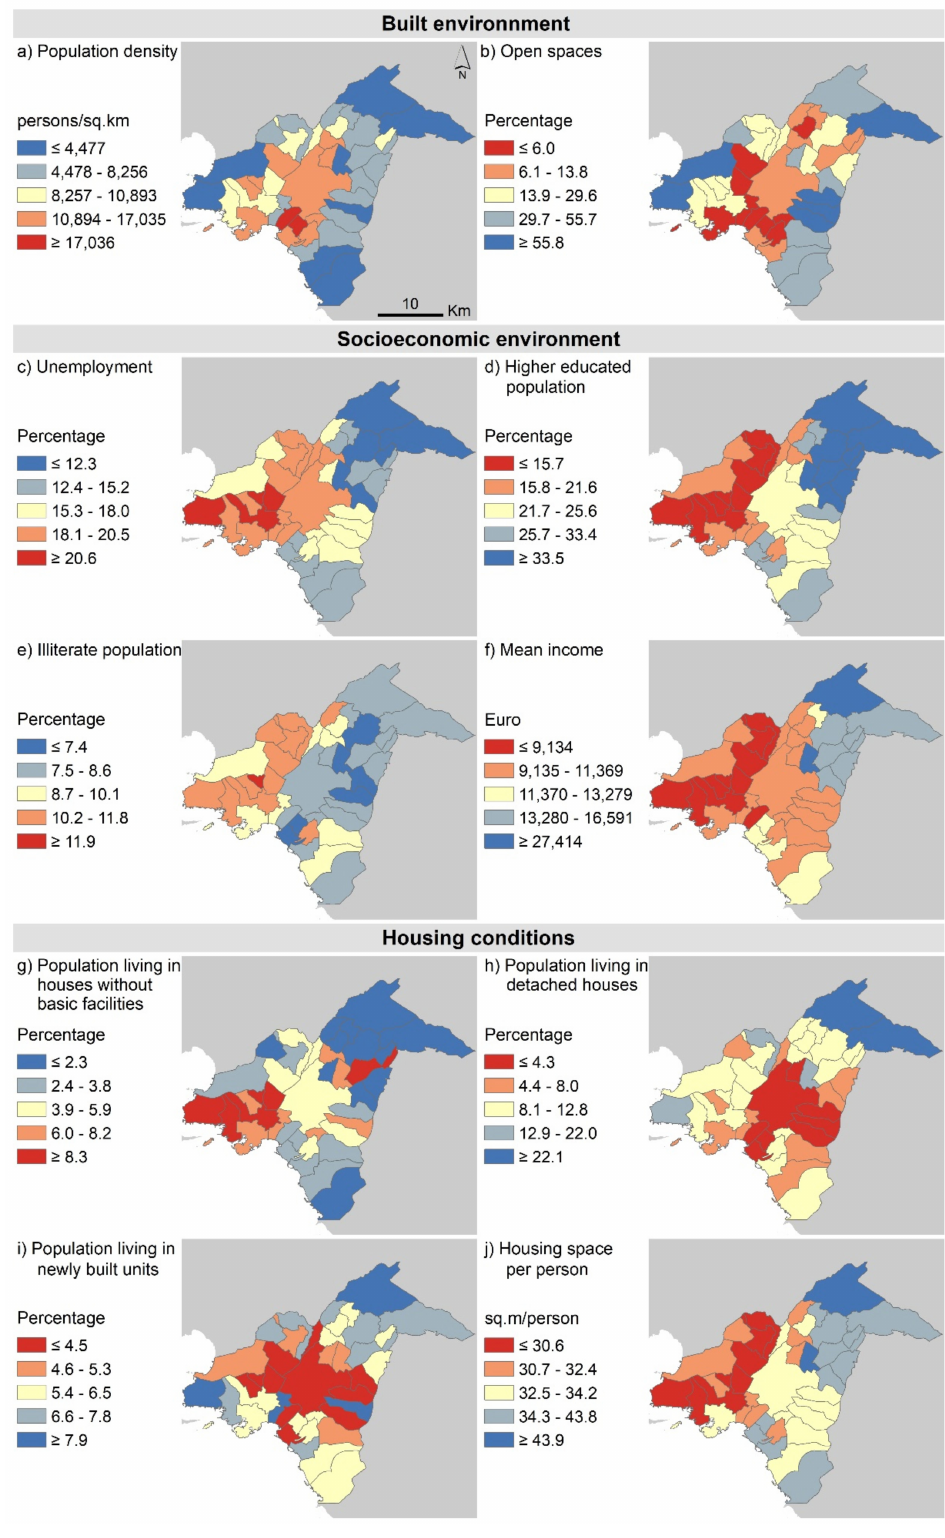
Figure 3. Indicators for the Built environment, Socioeconomic environment, and Housing conditions, across municipalities of AMA, Greece. ( a ) Population density, ( b ) open spaces, ( c ) unemployment, ( d ) high-educated population, ( e ) illiterate population, ( f ) income, ( g ) houses without basic facilities, ( h ) detached houses, ( i ) new buildings, ( j ) size of houses. (Red color in each map indicates low QoL and blue color high QoL